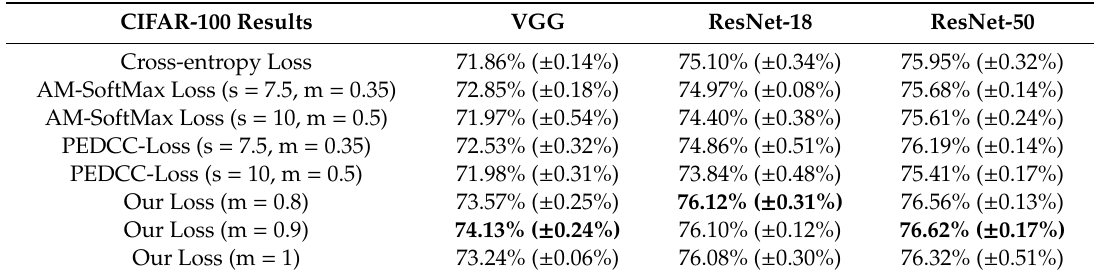
Table 1. The experimental results of CIFAR-100 dataset.